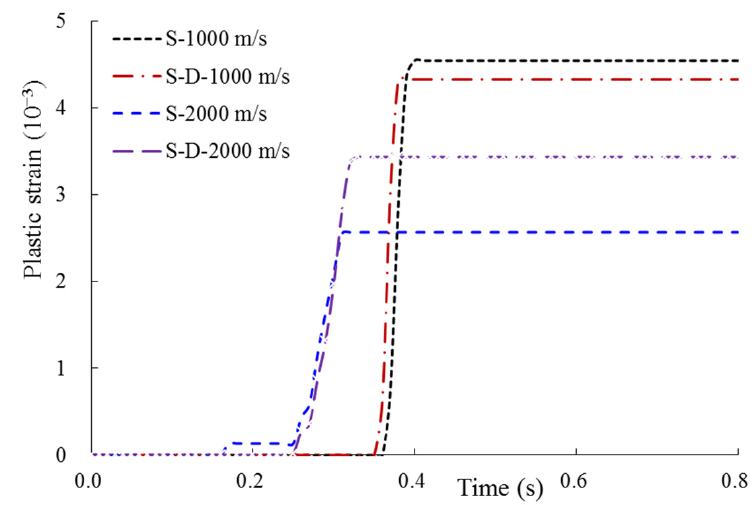
Figure 15. Max displacement time-histories of containment.